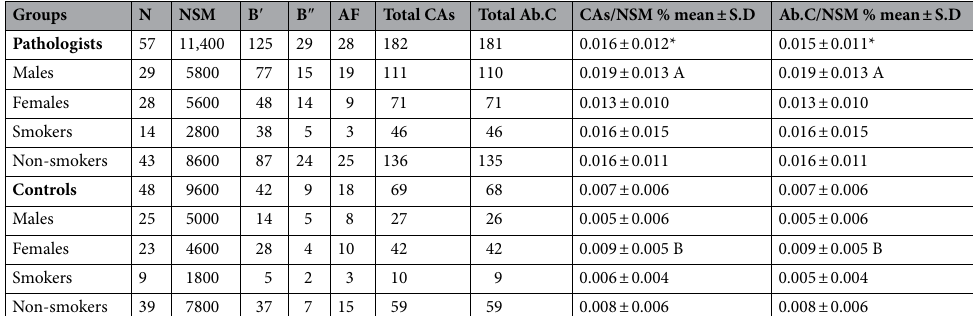
Table 2. Frequencies of chromosomal aberrations and cells with aberrations in metaphases of lymphocytes from studied subjects. N number of analysed subjects, NSM number of scored metaphases, B ′ chromatid breaks, B ″ chromosome breaks, AF acentric fragments, CAs chromosome aberrations, Ab.C cells with aberrations, S.D. standard deviation. *P < 0.001, Kruskal–Wallis, significantly higher with respect to Controls. A P = 0.046, Kruskal–Wallis, significantly higher with respect to Females. B P = 0.020, Kruskal–Wallis, significantly higher with respect to Males.